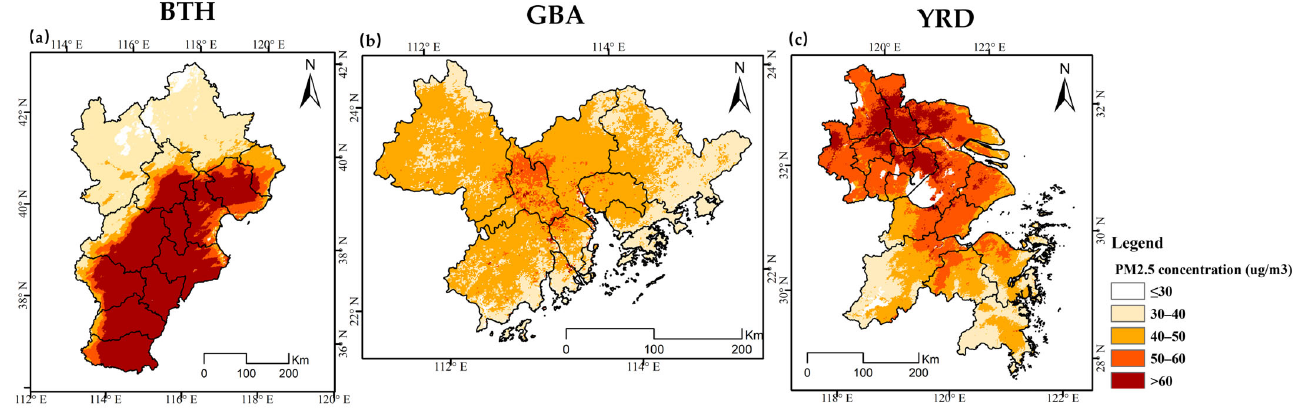
Figure 8. Spatial stratification of the air environmental situations in the three UAs: ( a ) BTH, ( b ) GBA, and ( c ) YRD.